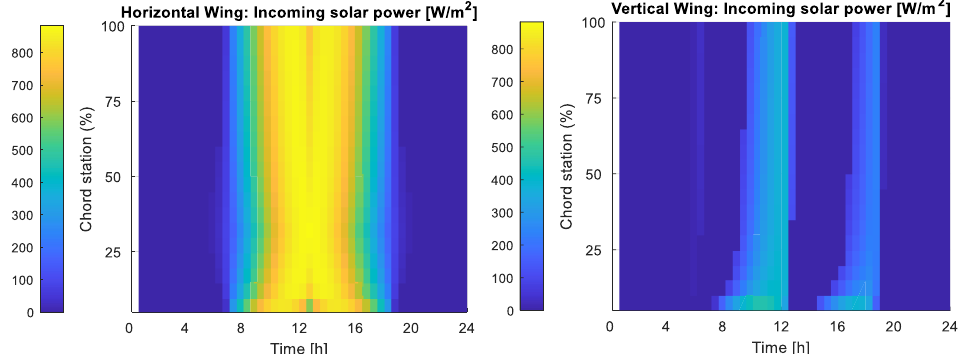
Figure 7. Examples of incoming solar power maps for a horizontal ( left ) and vertical ( right ) wings with assigned airfoil and mission profile.